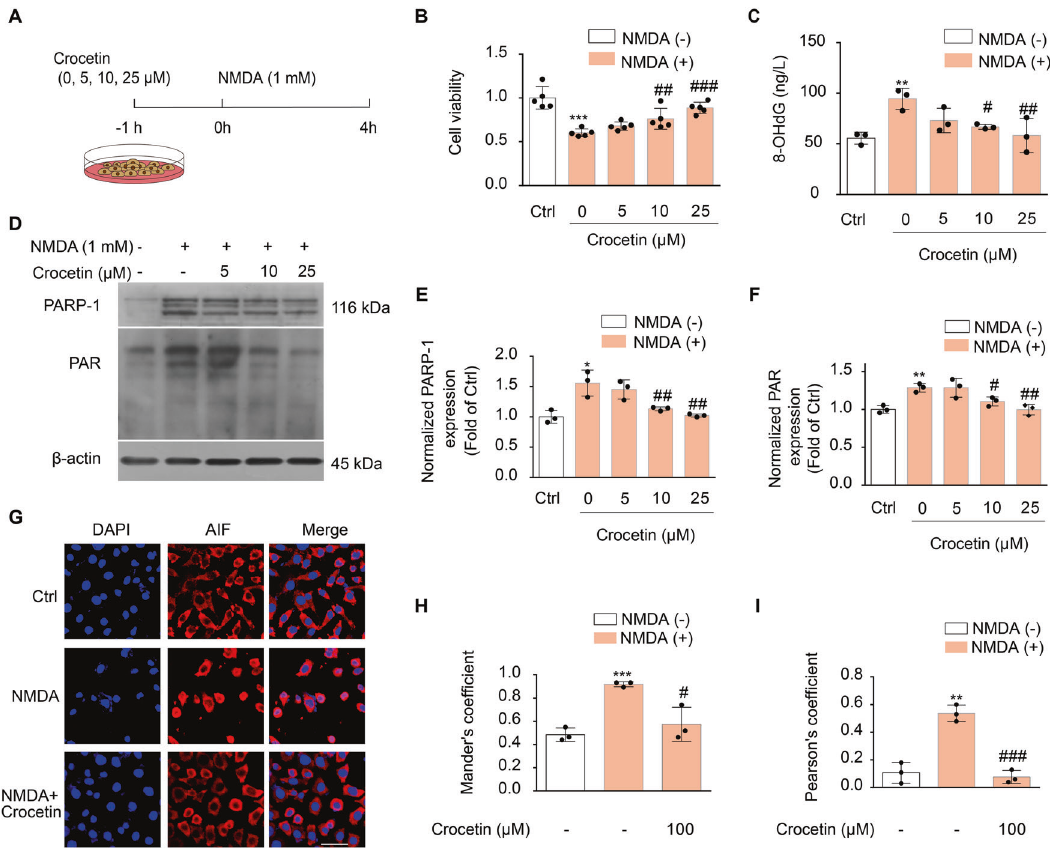
Fig. 3 Crocetin protected neurons against excitotoxicity-induced parthanatos. A Scheme diagram of the experiment. Cells were pre- incubated with indicated concentrations of crocetin for 1 h before NMDA (1 mM) stimulation for 4 h. B Cell viability of SH-SY5Y cells determined with MTT assay. C NMDA-induced 8-OHdG in SH-SY5Y cells. D NMDA-induced PARP-1 and PAR expression in SH-SY5Y cells. E Group quanti fi cation of PARP-1 in ( D ) from three independent experiments. F Group quanti fi cation of PAR in ( D ) from three independent experiments. G Confocal images of SH-SY5Y cells immuno-stained with AIF-speci fi c antibody (red) and DAPI (blue). Cells were pretreated with crocetin (25 μ M) for 1 h before NMDA (1 mM) stimulation for 4 h. Scale bar: 20 μ m. H Colocalization coef fi cient between AIF and DAPI measured as Mander ’ s coef fi cient. I Pearson ’ s correlation coef fi cient between AIF and DAPI staining. Signi fi cance was determined by one-way ANOVA. * p < 0.05, ** p < 0.01, *** p < 0.001, vs. control group; # p < 0.05, ## p < 0.01, ### p < 0.001, vs NMDA